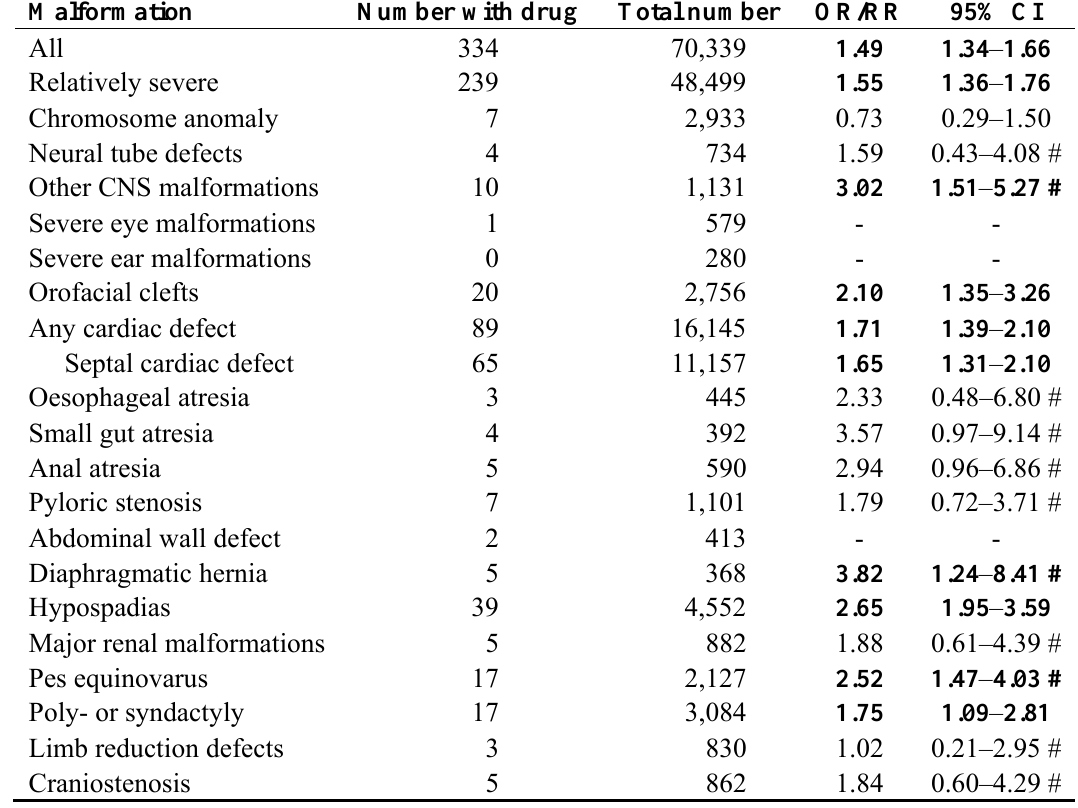
Table 12. Presence of congenital malformations in infants whose mothers used anticonvulsants in early pregnancy. Bold text marks statistical